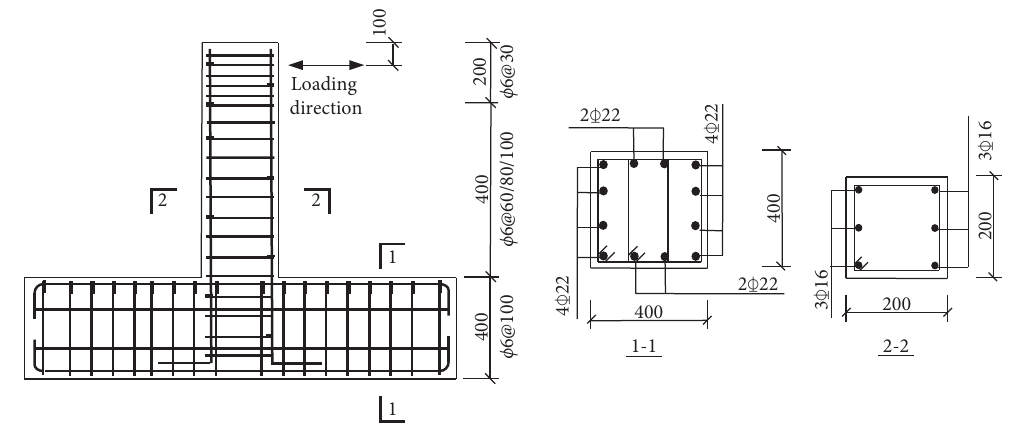
Figure 1: Geometric dimensions and steel bar layout of the column specimens (unit: mm). Table 1: Main test parameters of the column specimens.